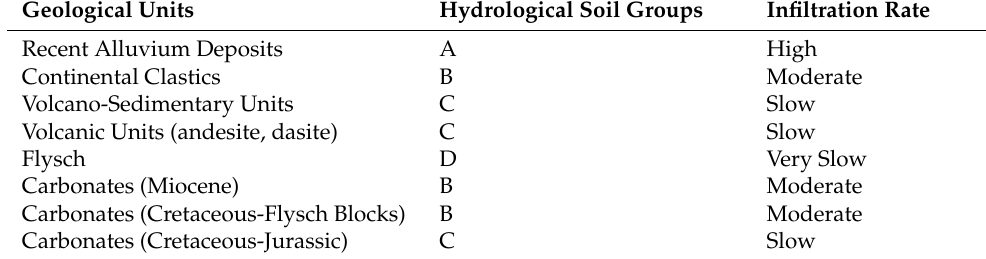
Soil hydrologic group’s raster map has pixel values ranging from 1, 2, 3 or 4, corre- sponding to soil hydrologic groups A, B, C or D, respectively. The map has been created while making a parametric association between the geological units map of Izmir and the hydrological classification (see Table 3 and Figure 3). Table 3. Hydrological soil group classification of geological units around İ zmir. Table 3. Hydrological soil group classification of geological units around ˙Izmir.